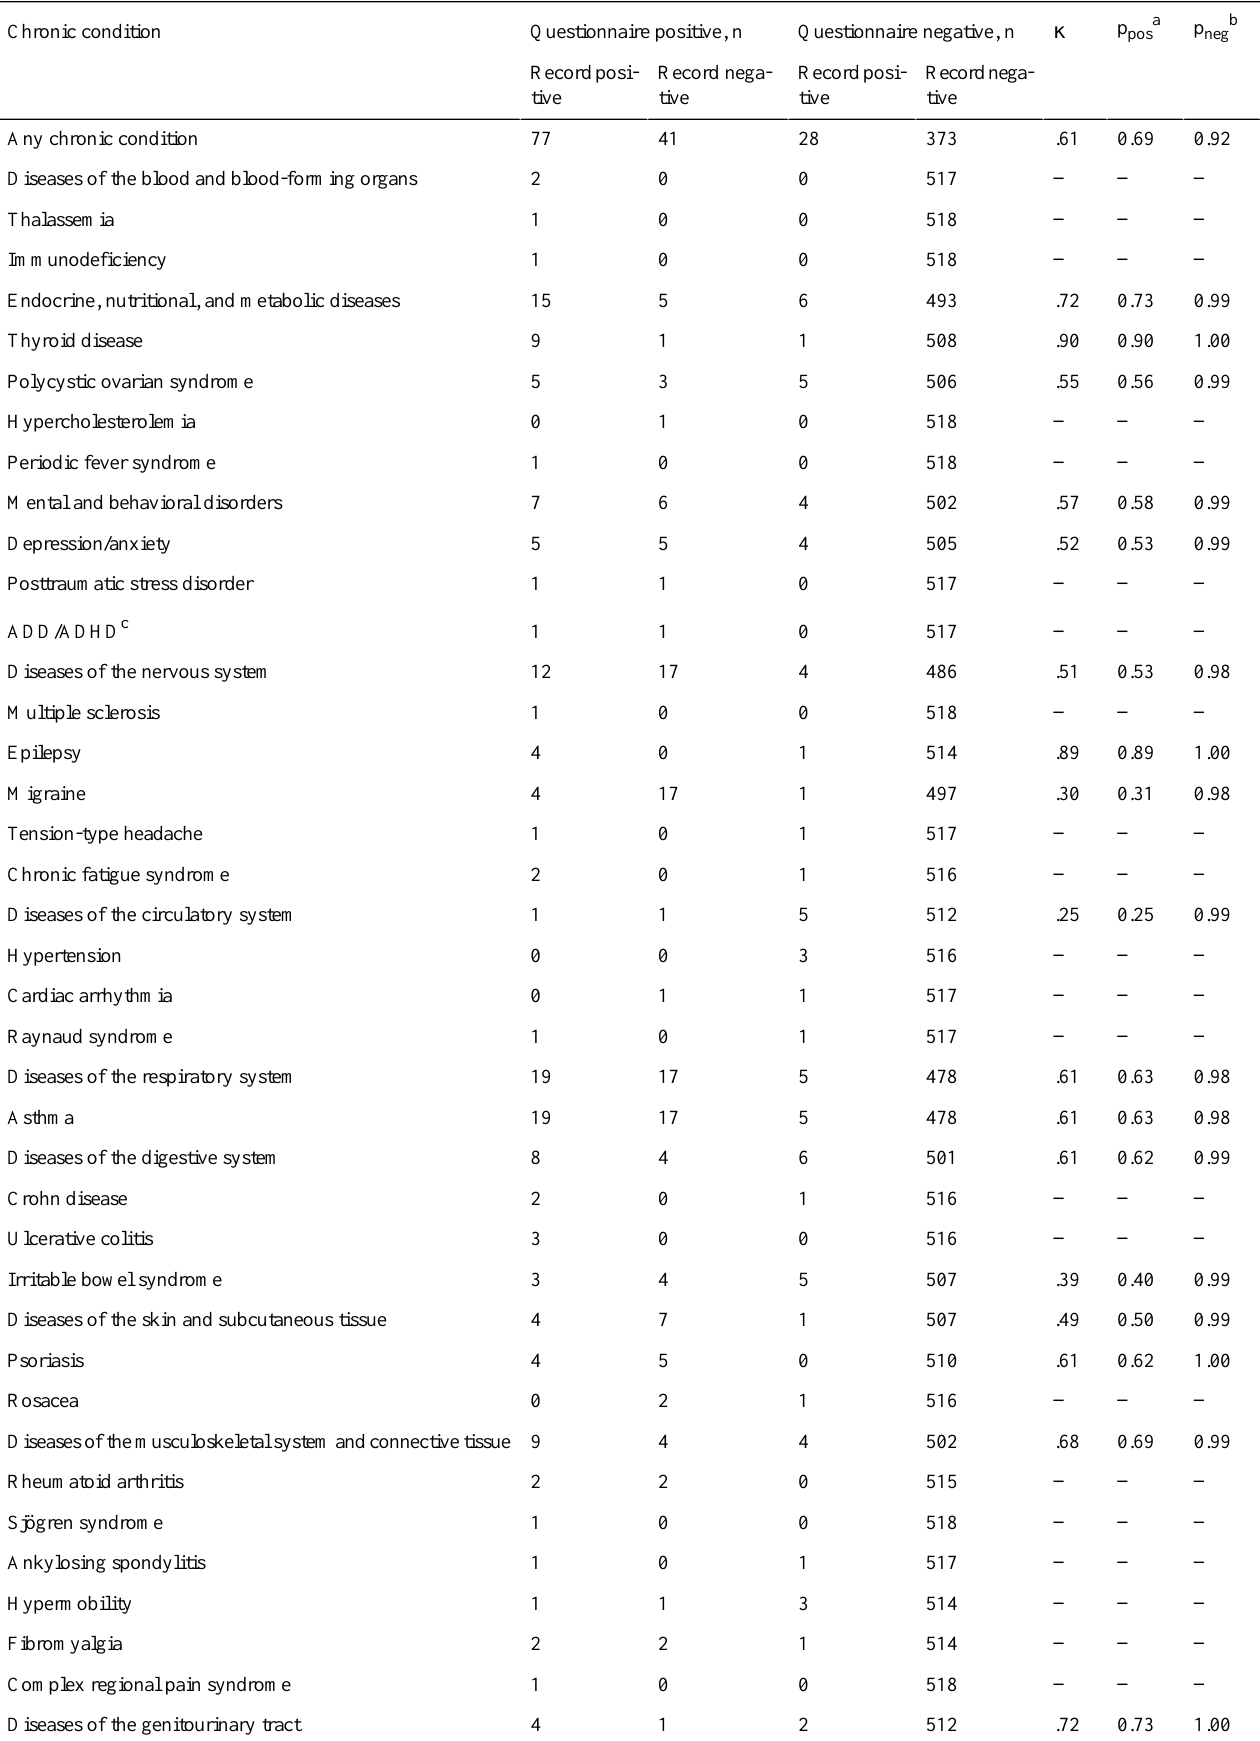
Table 2. Agreement between data from the Web-based questionnaire and obstetric record for chronic conditions